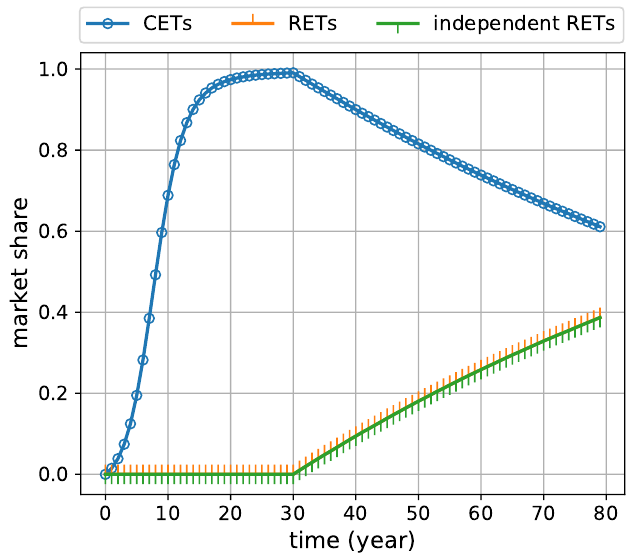
Figure 7. The competition between two technologies entering the market with different timings. CETs, conventional energy